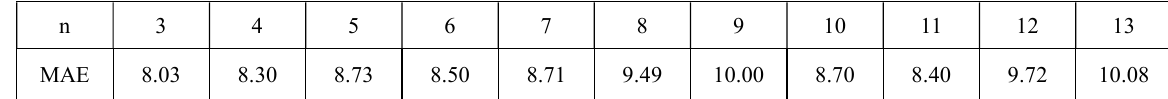
Table 1 The relation between the number of hidden layer nodes and MAE